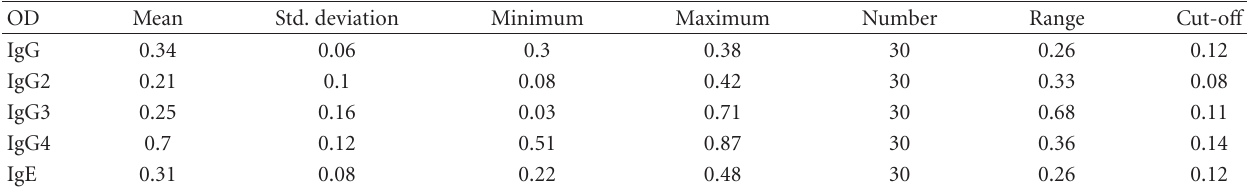
Table 3: The mean OD values of IgG class and subclass responses of 30 naturally infected hyadid patients against sheep cystic crude fluid antigens.